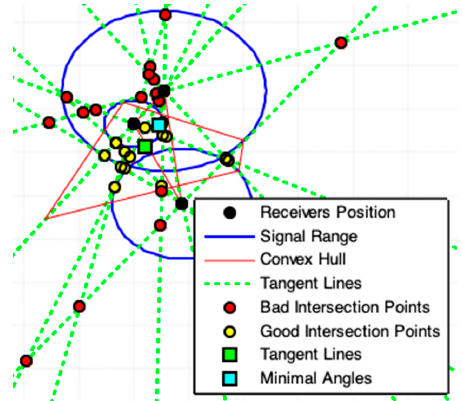
Figure 13. Geometric incoherence. The receiver is placed inside the range of another receiver. The geometric models TLI and MAI are able to overcome this data inconsistency and produce a satisfactory result. Algorithm 5. MAI—Tangent Lines with Minimal Angles Intersections Model Algorithm Data Input